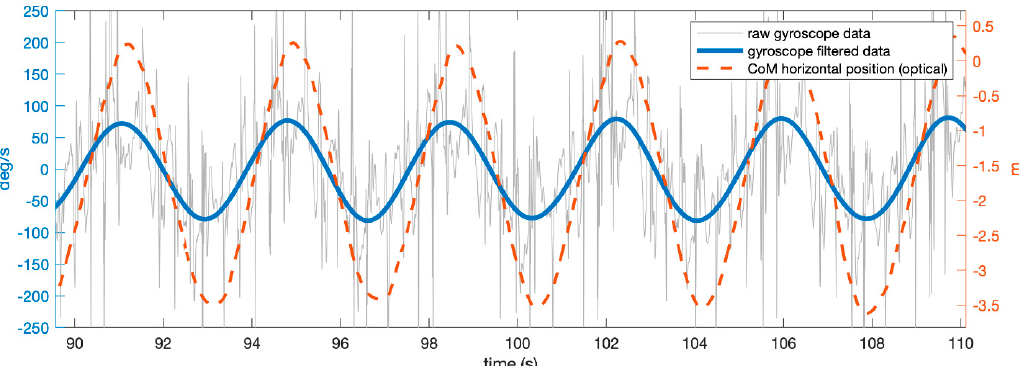
Figure 3. Events detection, based on center of mass (CoM) horizontal position (red curve, referred to the origin of the laboratory global reference system) and raw/filtered gyroscope rotation around the vertical axis (gray and blue, respectively). The autocorrelation function between the two allowed us to synchronize the two measurement systems.